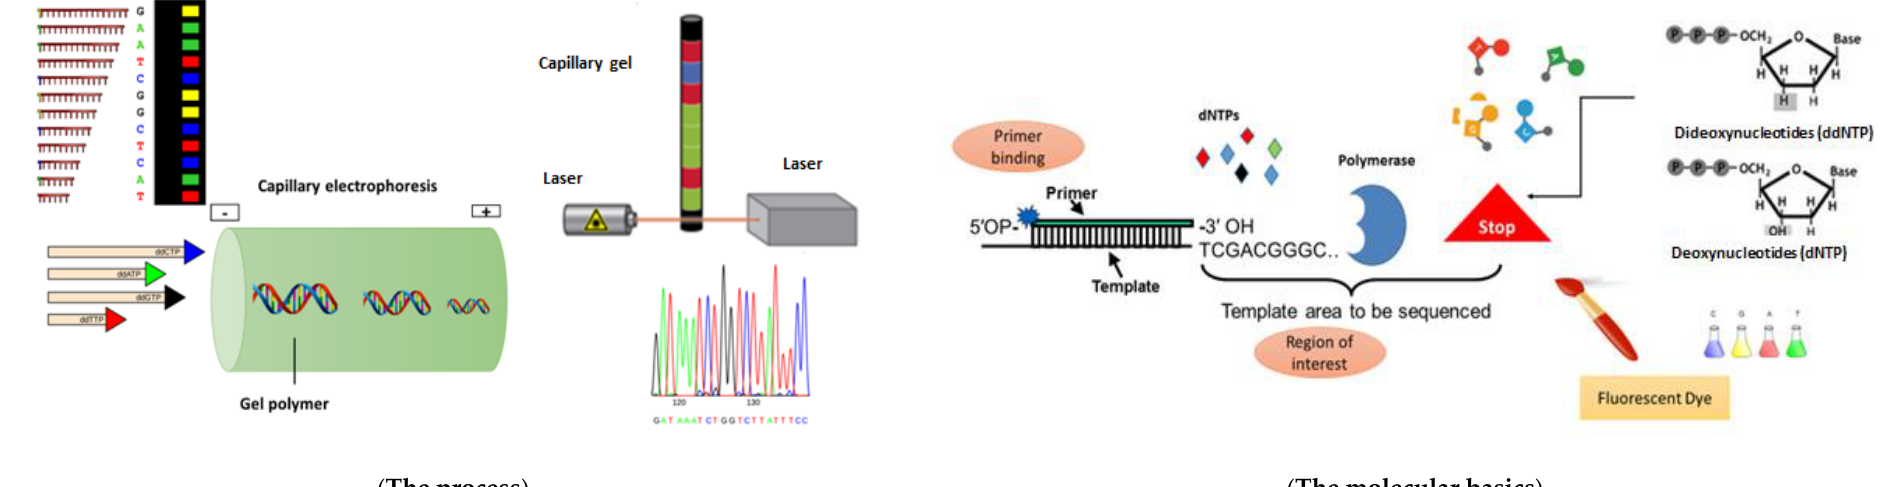
Figure 1. Schematic representation of the Sanger sequencing process. The Sanger sequencing method uses a high-fidelity DNA-dependent polymerase to create a single strand of DNA that is complementary to the DNA template [66,69]. The synthesis reaction commences at the 3′ end with a single primer that is complementary to the template. Deoxynucleotide (or nucleotide) monomers, which are the building blocks of DNA, are sequentially added in a template-dependent manner. These form phosphodiester bonds between the 3′ hydroxyl of the primer and the 5′ triphosphate of the next nucleotide to be added to the sequence. The reaction mixture also includes A, C, G, and T di-deoxynucleotides, which mimic DNA monomers sufficiently to be incorporated into the sequence. Yet, unlike deoxynucleotides, the absence of the critical 3′ hydroxyl means there is no binding facility for incoming nucleotides, preventing further elongation. Furthermore, a fluorescent tag is incorporated into the di-deoxynucleotides enabling the DNA sequence to be automatically detected [66,67]. Each reaction is based on multiple copies of DNA fragments of different lengths, but always terminating in a di-deoxynucleotide at the comparable nucleotide position of the template molecule. The automatic process loads reaction mixtures onto sequencing machines with capillaries and uses electrophoresis to separate the DNA molecules based on their molecular weight, which varies according to the point at which the fragments terminate. As the di-deoxynucleotides pass through the gel, the fluorescent emission is read to determine the DNA sequence. As each of the four nucleotides fluoresces with a different colour, a four-colour chromatogram can be used to interpret the sequence. Capillary-based automated electrophoresis forms the basis of modern-day Sanger sequencing, and the devices are able to simultaneously analyse 8 – 96 sequencing reactions [67].